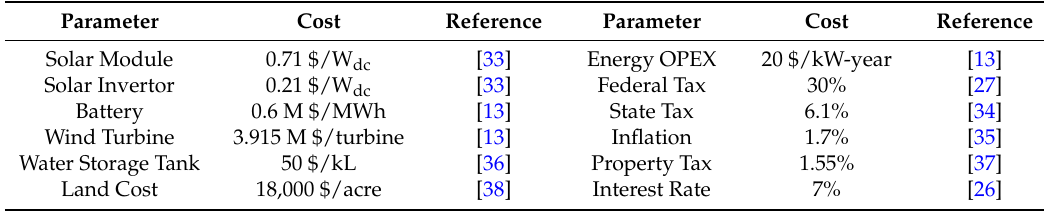
Table 3. The main variables employed in SAM models.